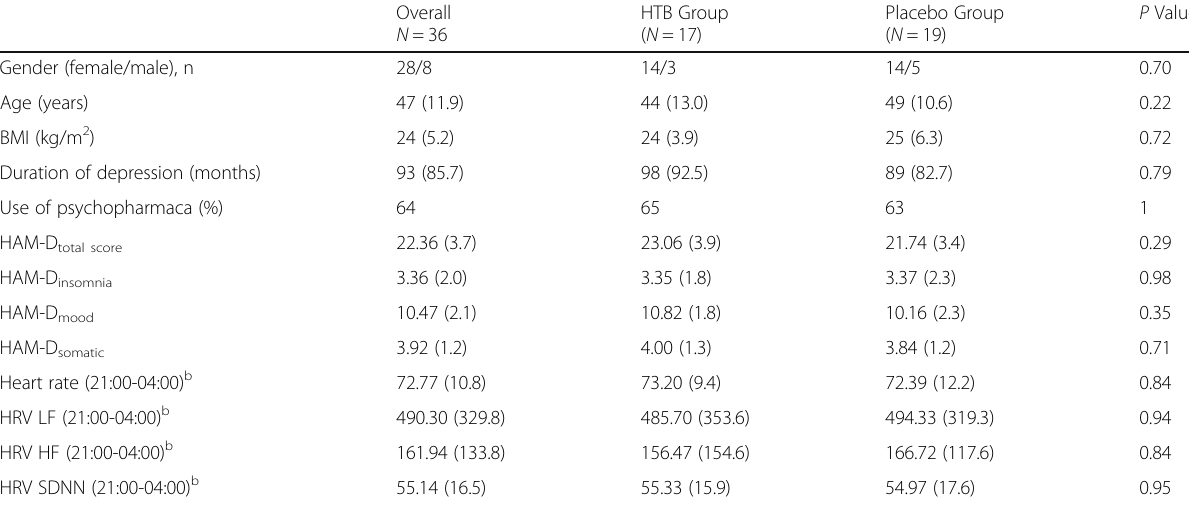
Table 2 Baseline demographic and clinical characteristics of the 36 randomized study patients (intention-to-treat population) by treatment